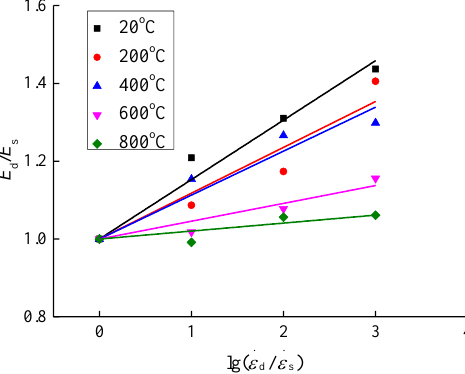
Figure 13. Elastic modulus of concrete.